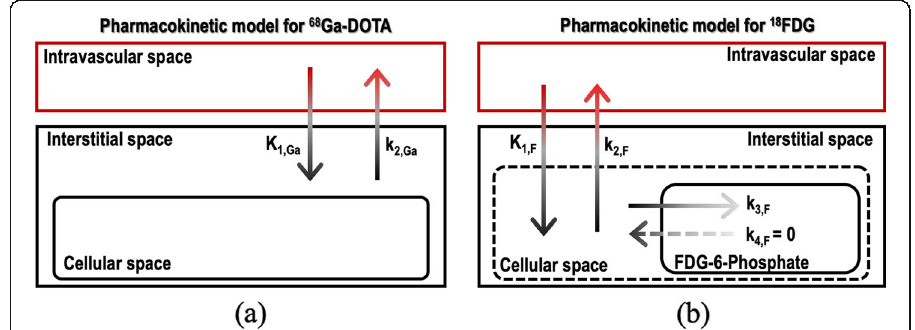
Fig. 5 Kinetic compartment models for 68 Ga-DOTA ( a ) and 18 FDG ( b ). The model for 68 Ga-DOTA is a single-tissue compartment model as the radiotracer diffuses bidirectionally between the intravascular space and extravascular extracellular space (interstitial space). The model for 18 FDG is an irreversible two-tissue compartment model as